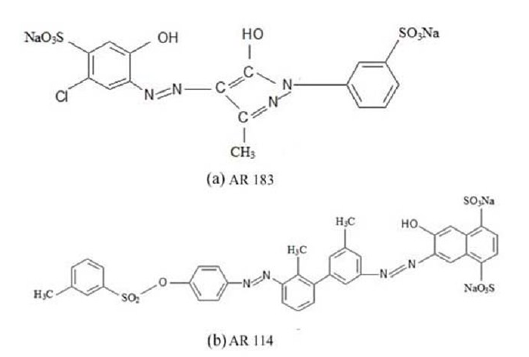
Figure 2. Molecular structures of (a) AR183, (b) AR114.